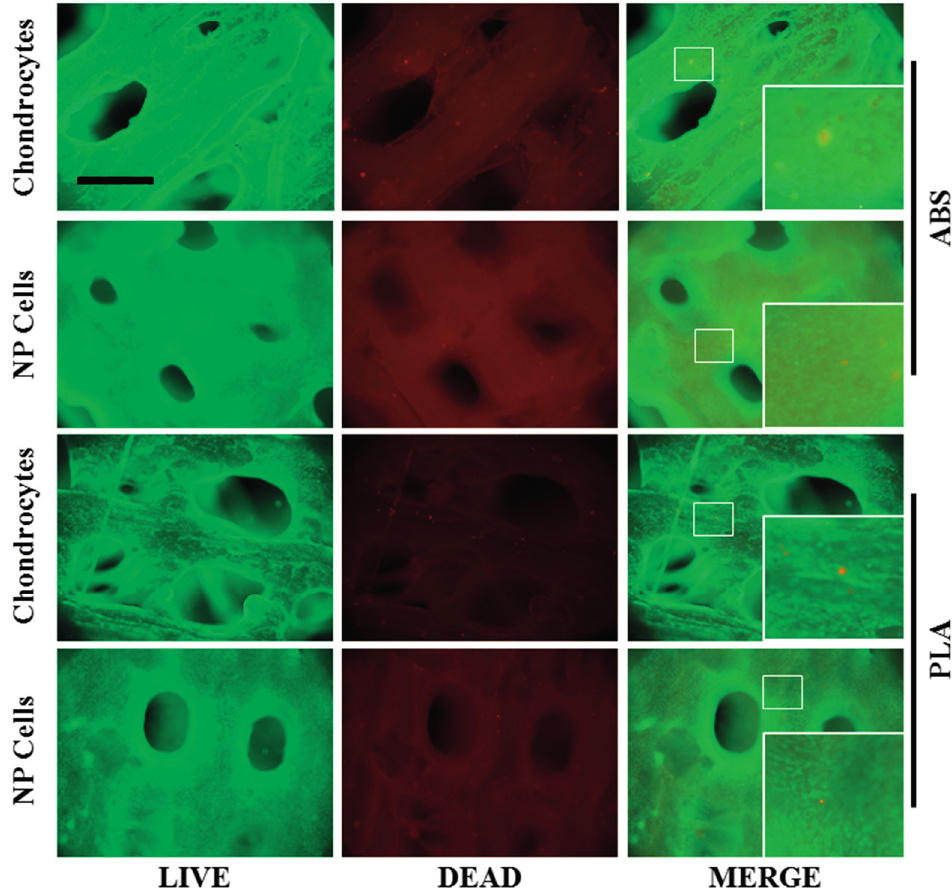
Figure 4. Cell viability on ABS and PLA scaffolds. Live/dead assay was performed on chondrocytes and NP cell-seeded ABS and PLA scaffolds after 21 days’ culture. Live cells are shown in green (calcein AM) while dead cells are shown in red (ethidium homodimer). Representative images ( n = 4) show that the number of dead cells on either scaffold is negligible. Inset panels are enlarged 3× from indicated regions, and show individual live and dead cells. Scale bar: 1.0